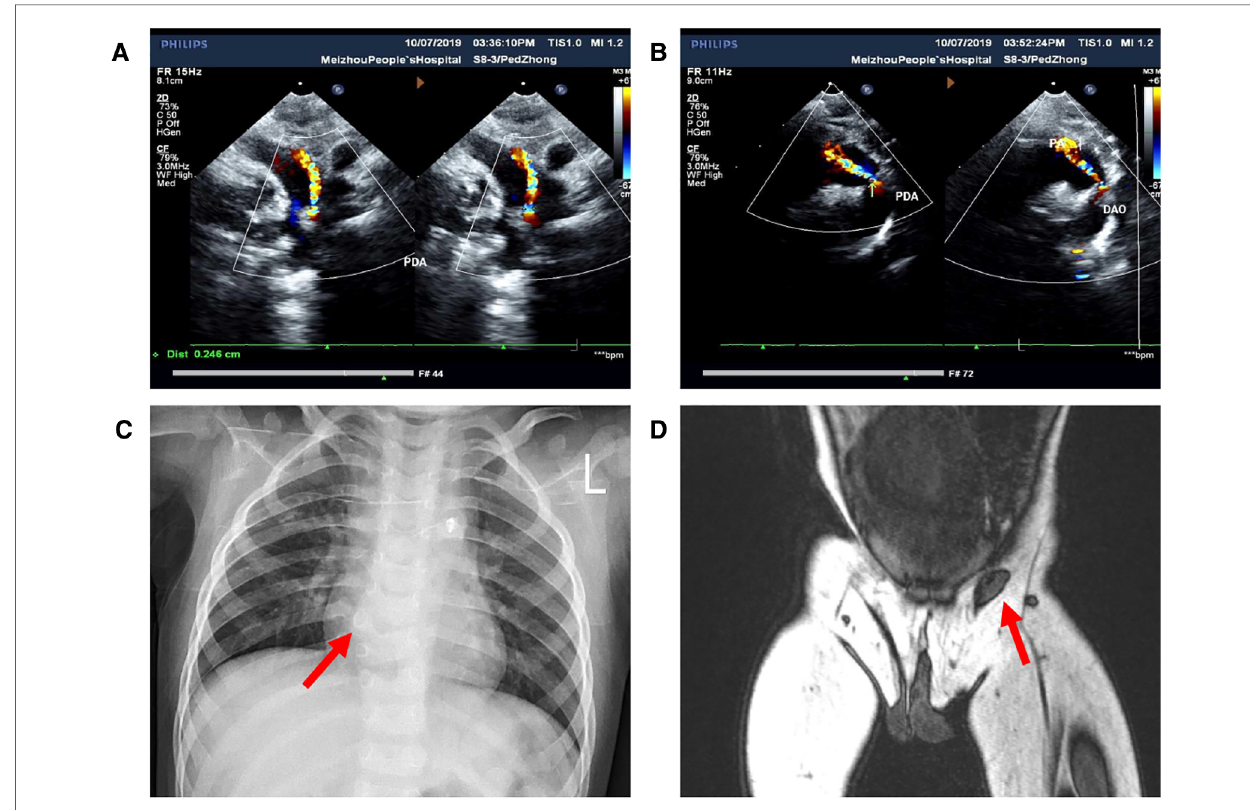
FIGURE 2 Images of preoperative auxiliary examination. ( A,B ) Patent ductus arteriosus detected by ultrasonic cardiogram; ( C ) hemivertebra deformity of the T8 vertebra detected by x-ray; ( D ) location of the left testis detected by